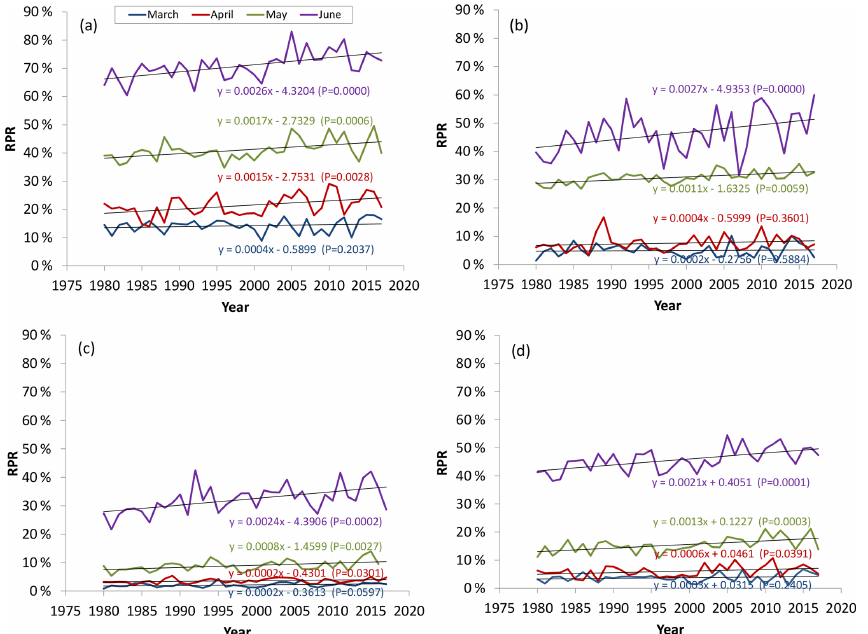
Figure 4. Time series of monthly rainfall–precipitation ratio (RPR) averaged over the Arctic Ocean for (a) ERA-I, (b) JRA-55, (c) MERRA, and (d) ERA5.